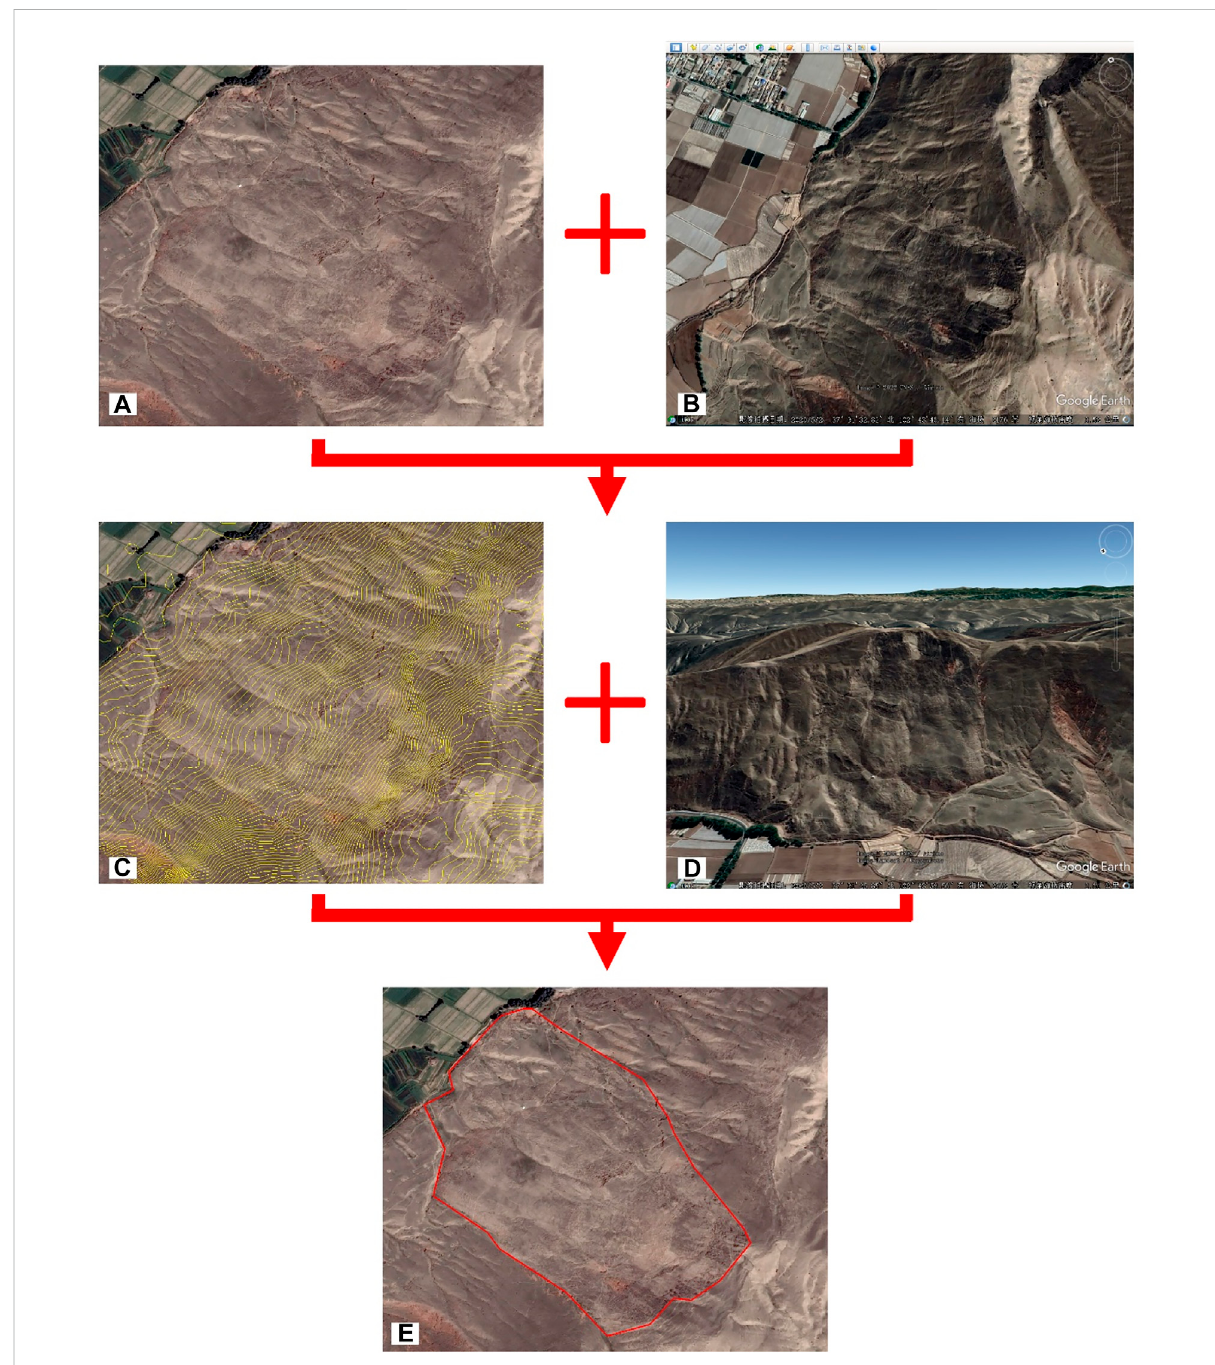
factors (seismic intensity, slope angle, elevation, slope aspect, fault belt, water system, and relative elevation difference) and seismic landslides. In this study, the spatial distribution of seismic landslides is analyzed by using four